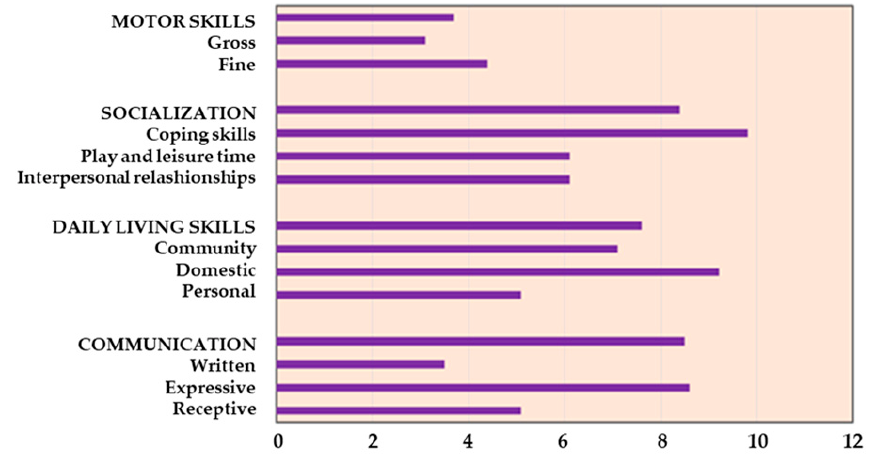
Figure 1. Evaluation of equivalent age according to Vineland Adaptive Behavior Scales. All 13 patients completed the assessment at T1.